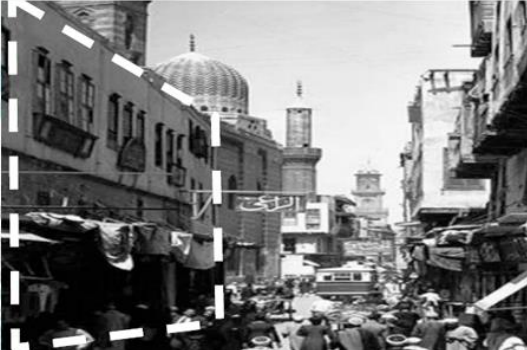
Figure 1. Location of Wikāliẗ ạl - ’Anbariyin . The black rectangle indicates Wikāliẗ ạl - ’Anbariyin. The black dashed line indicates ạl-Muʿiz Street. The black continuous line indicates Harit Tarbi'at Ūwf. (Source: Google Earth Pro. (October 12, 2018)).